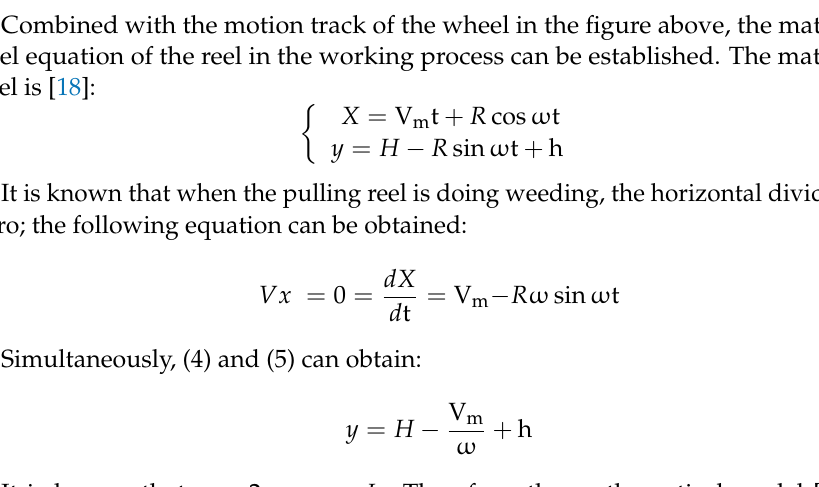
Figure 7. Motion track of the